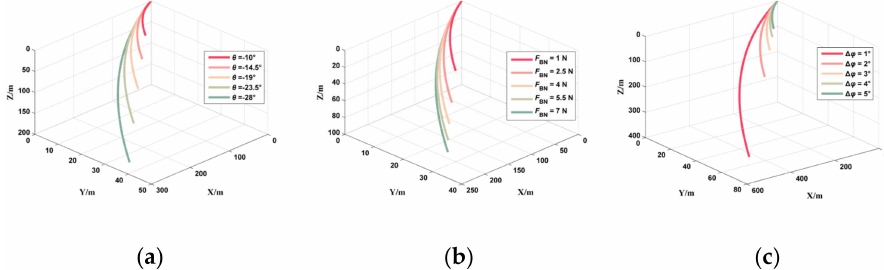
Figure 5. Three-dimensional trajectory of Petrel-L under different pitch angles ( a ), net buoyancies ( b ), and rotation angle errors ( c ).